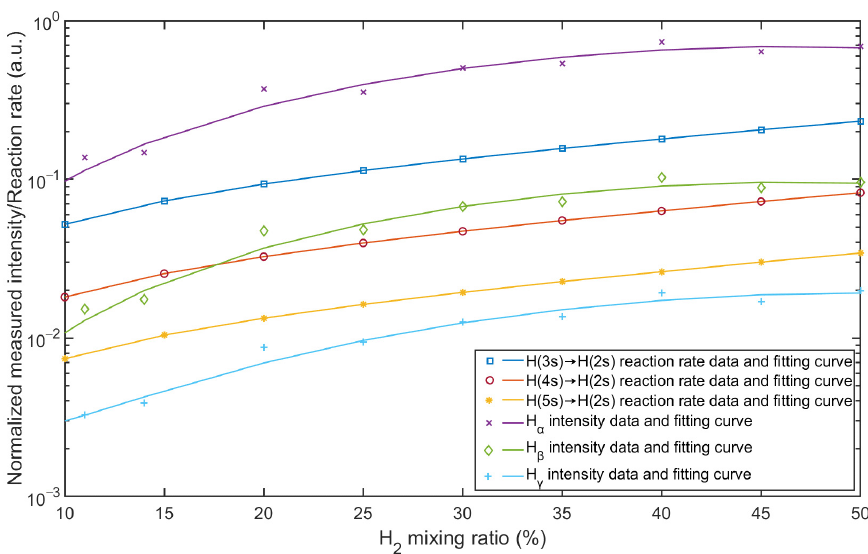
Figure 8. Comparison between normalized measured intensity and simulated reaction rate as a function of Ar/H 2 mixing ratio.